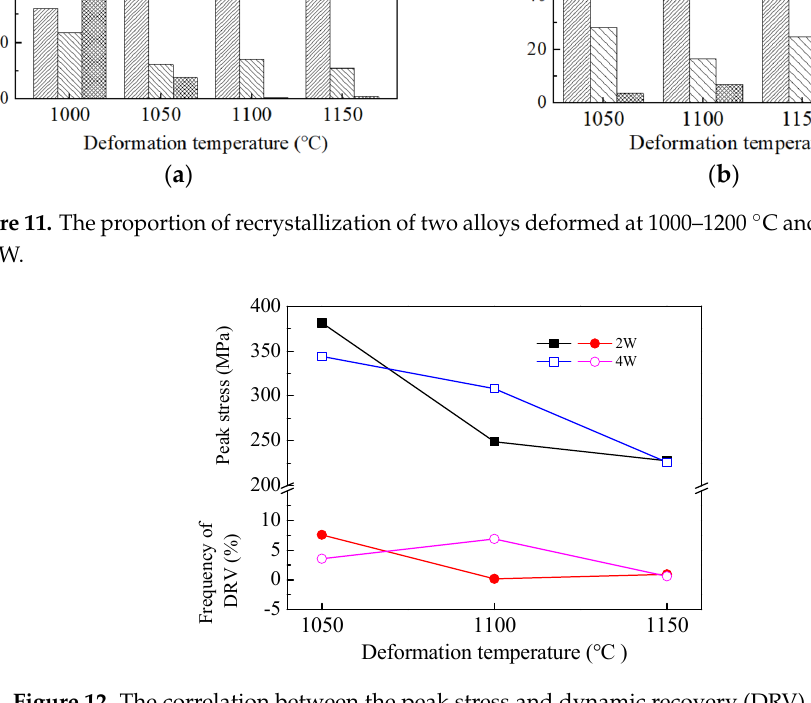
Figure 12. The correlation between the peak stress and dynamic recovery (DRV) fraction.